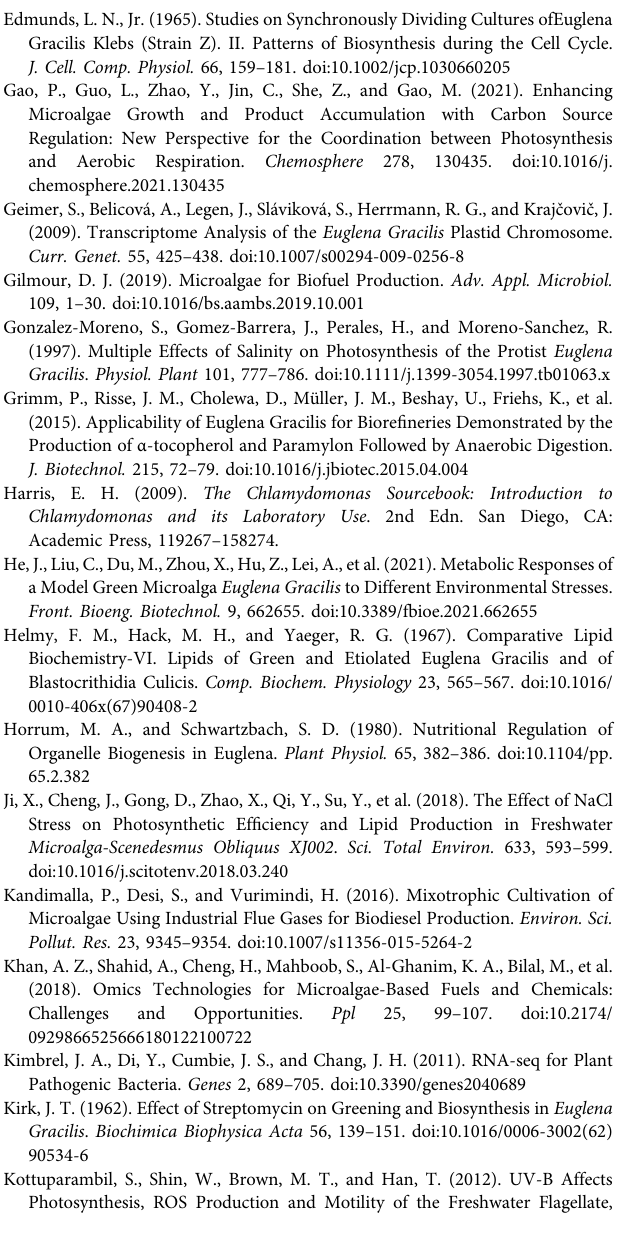
Supplementary Figure S1 | Functional categorization of up- (red color) and down- regulated (blue color) genes in E. gracilis under different treatments based on gene ontology (GO) annotations. BP, biological process, CC, cellular components, MP, molecular functions. Supplementary Figure S2 | Bubble plots of DEGs for visualizing KEGG pathway enrichments. Bubble size indicates the log size of the KEGG term, enrichment of the down-regulated genes (down KEGG), and up-regulated genes (up KEGG). Supplementary Table S1 | The contents of fatty acids in the unit cell of E. gracilis under different treatment conditions (pg/cell). Treatments include supplementation withparomomycin(PRM1,5,25as1,5,25 µg/mL),ethanol(E0.5,1.0,1.5as0.5,1, 1.5% vol/vol), glucose (G0.5, G1.0, G1.5 as 0.5, 1.0, 1.5% weight), CdCl2 (Cd0.5, Supplementary Table S2 | The Log2FC (fold change) of selected fatty acid metabolism genes under different treatments, treatment vs.